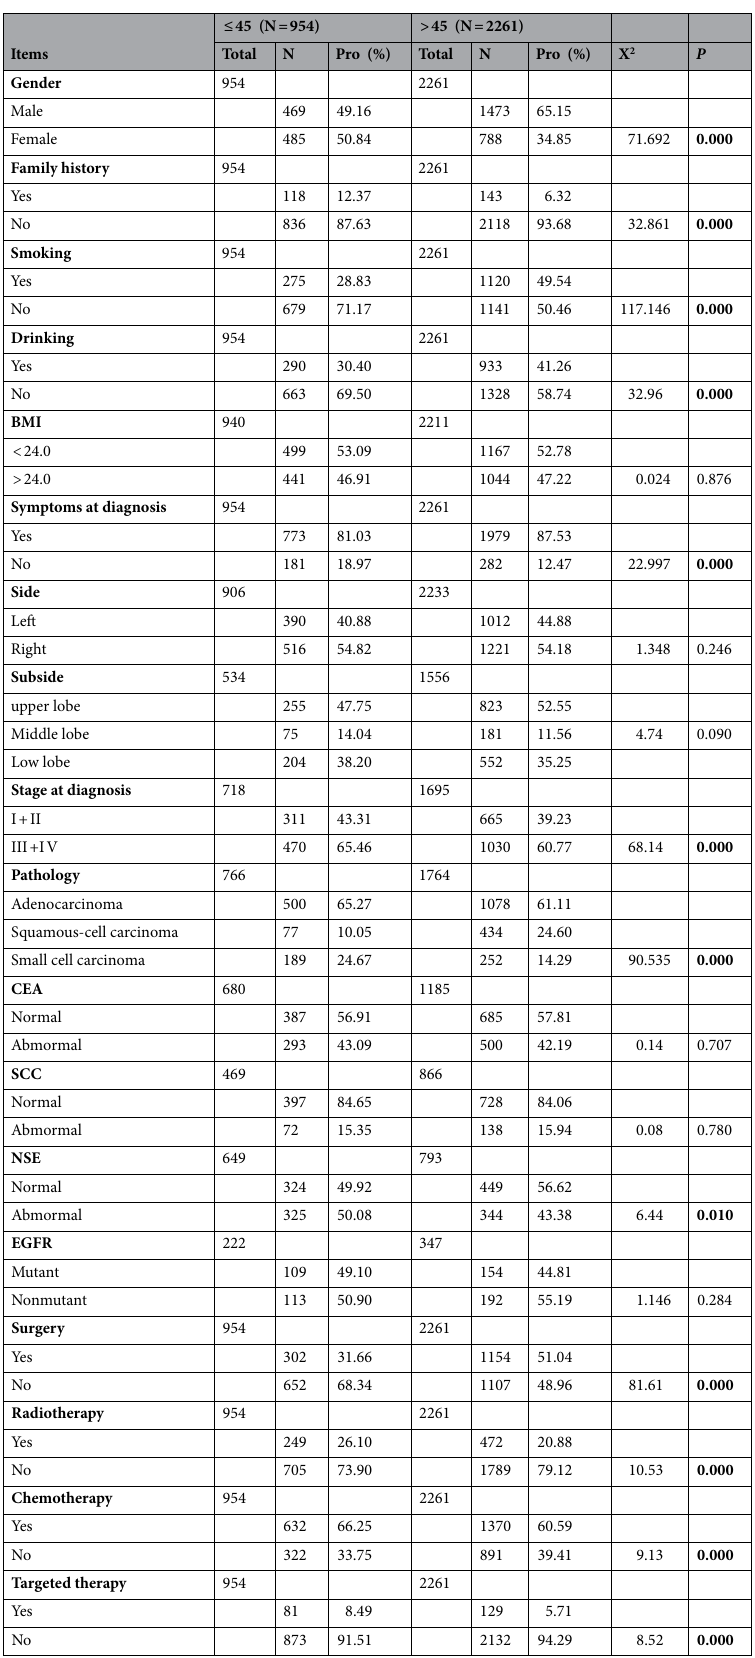
Table 2. The characteristics of lung cancer patients by hospital-based